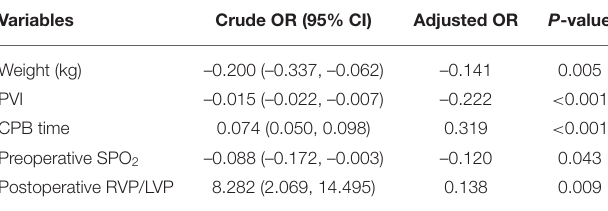
TABLE 5 | Linear stepwise regression analysis of risk factors for VIS.